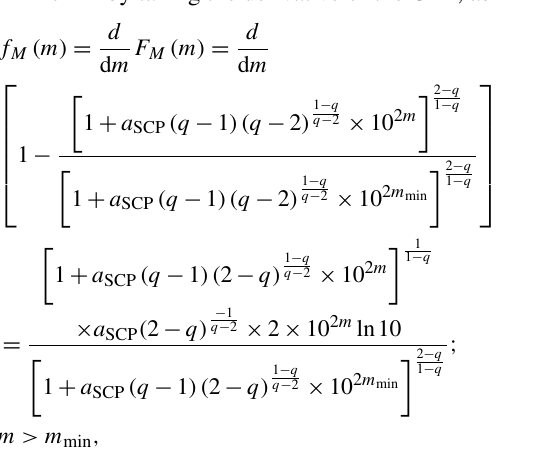
Figure 2. Comparison of ECDF of observed and declustered data with the GR and SCP models.